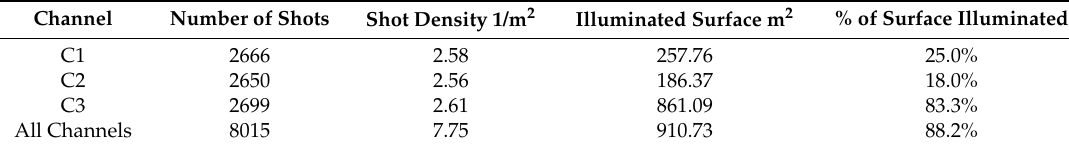
Figure 11. Illustration of Titan’s footprints and surface illumination from a single pass of the sensor. ( a ) Intensity rendering of a test swath generated from Titan channel 1; ( b ) Graph that plots the position and footprints of returns from all of Titan’s channels for the red square sample of the test swath. This graphs illustrated how much of the target surface is illuminated by the laser beams. This test flight swath was collected by Teledyne Optech during the first test flight of the Titan system. The system was configured with a PRF of 200 kHz per channel (600 kHz combined), a scan angle of ±25° and a scan frequency of 32 Hz (scan product of 800 degrees-Hertz) and flown at an altitude of 1000 m above ground level. In Figure 11b, the footprints for each of the returns for the three Titan channels are plotted at a proper scale. The footprints of the returns from channel 1 (1550 nm) are depicted in blue, while the footprints for channels 2 and 3 are represented with red and green, respectively. The sample square that was cropped from the swath has an area of 1033 m 2 , and the number of shots and the area illuminated by the laser footprints (not counting the overlap between footprints of the same channel) are summarized in Table 9. Due to the larger divergence of channel 3 (532 nm), the footprints from the laser shots illuminate 83.3% of the sample area, while a single infrared channel (channel 1) illuminates 25% of the sample area. When combining the footprints of the three channels, and not counting the area overlap, the fraction of the surface area that is illuminated by the main portion of the laser beams totals 88.2%. Of course, the surface illumination can be increased significantly by utilizing a 50% lateral overlap or by flying lines in an orthogonal fashion. This near-full-surface illumination is critical for other capabilities of the Titan sensor, for example canopy penetration, small target detection and active intensity image generation. Table 9. Shot densities and fraction of surface illuminated in a single pass of the Titan sensor.